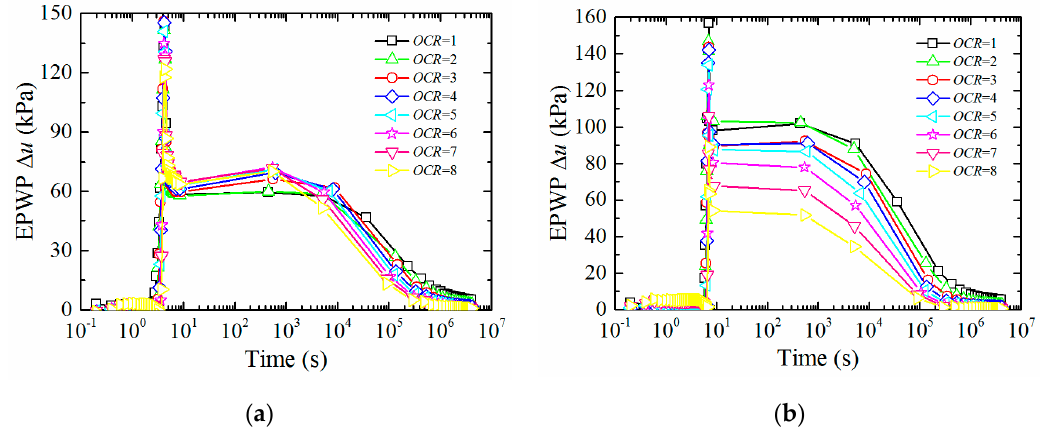
Figure 16. Development and dissipation of EPWPs at a distance of 0.2 m from the pile wall during and after pile installation under various OCR s. ( a ) At depth of 4.9 m; ( b ) at depth of 7.5 m.